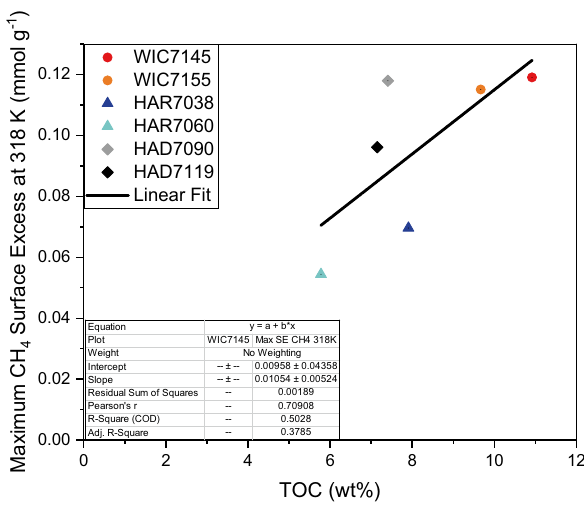
Fig. 13 The variation of maximum CH 318 K with TOC [34]